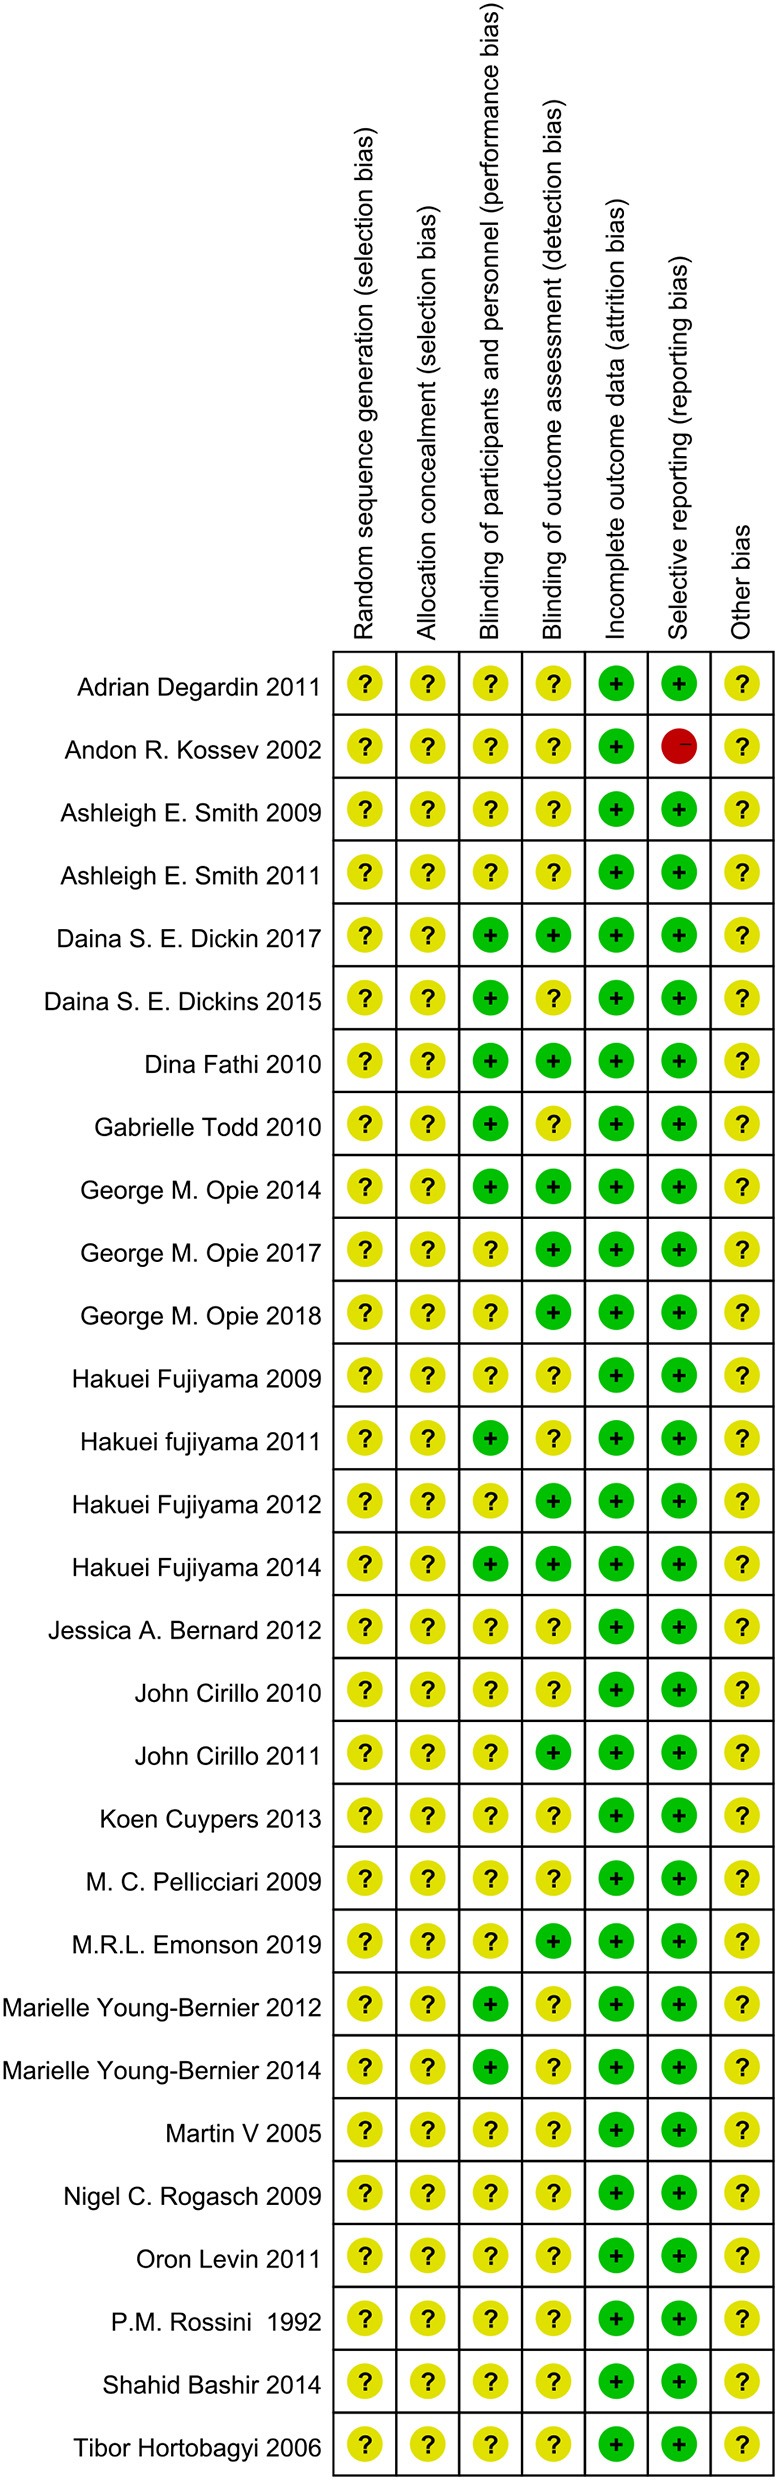
Summary Graph of the risk of bias in the included trials by Cochrane risk of bias toll based upon reviewers' judgment of each domain.